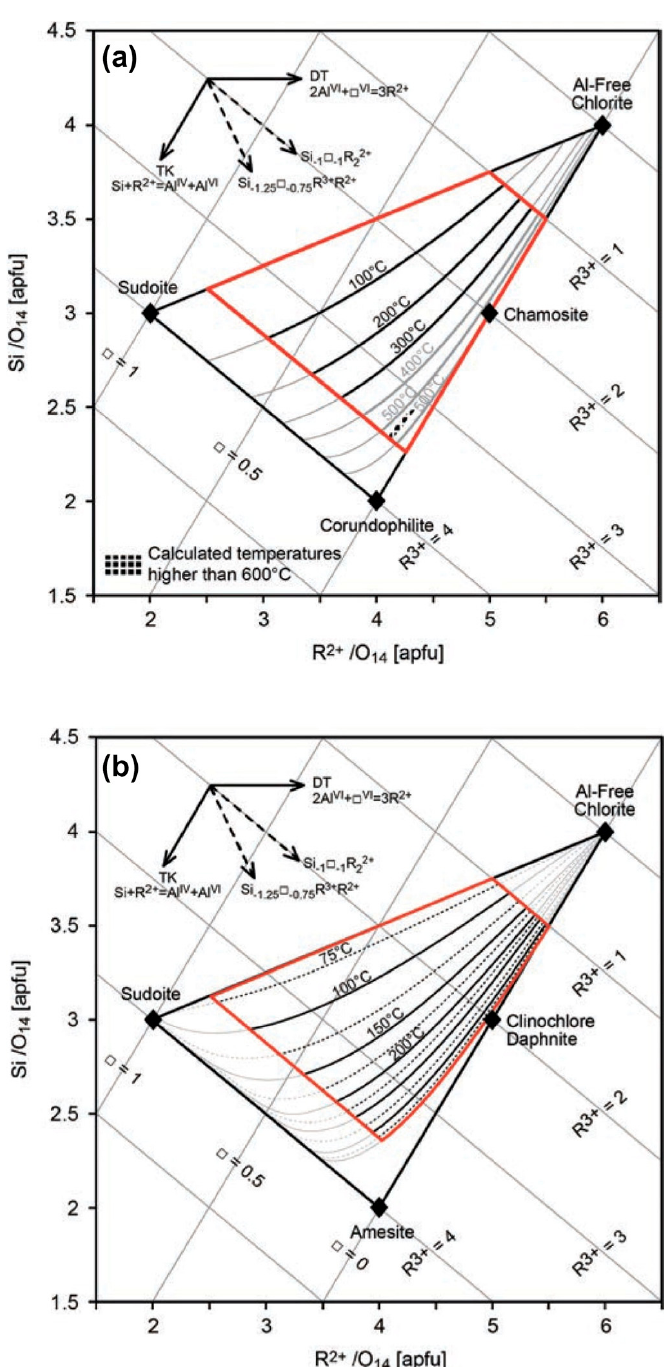
Figure 3. ( a ) Representation of isotherms (in 100 °C steps) calculated with the quadratic equation of Inoue et al. [29] thermometer in the R 2+ –Si diagram of Wiewiòra and Weiss [78]. ( b ) Representation of isotherms (in 25 °C steps) calculated with Bourdelle et al. [30] geothermometer in the T-R 2+ –Si diagram of Wiewiòra and Weiss [78]. The area of optimal reliability for the thermometer is shown in red. The two diagrams are from Bourdelle and Cathelineau [77], reproduced with permission from the European Journal of Mineralogy.